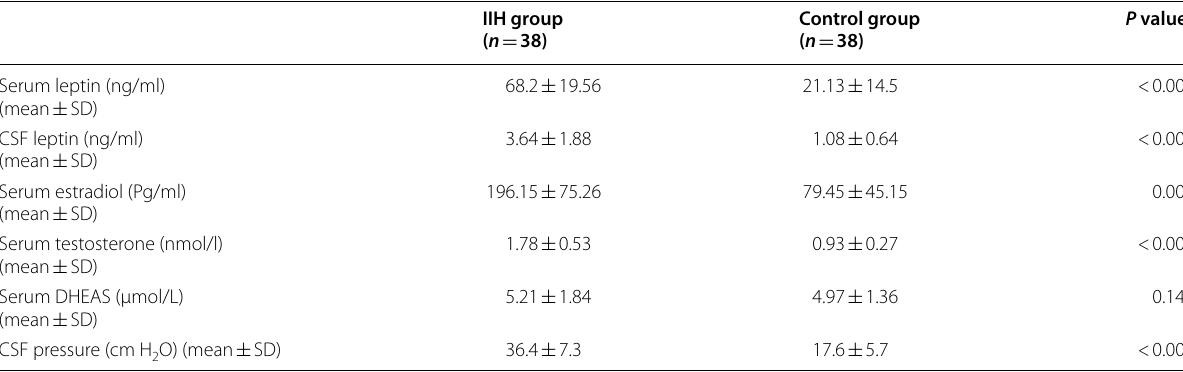
Table 2 Laboratory data and CSF pressure in IIH and control